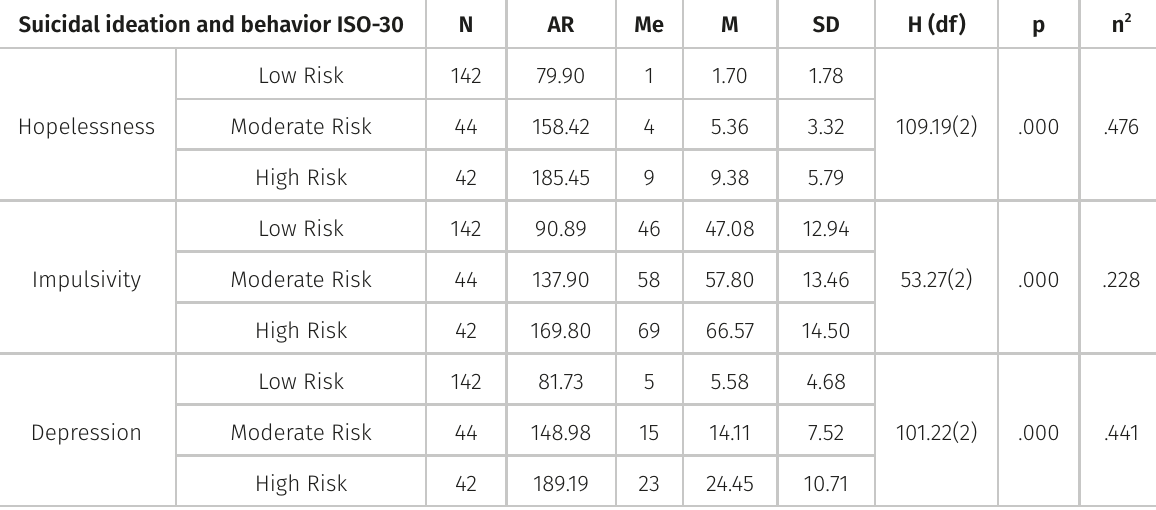
Table I. Differences between students based on the risk of suicidal ideation and behavior and the variables of hopelessness, impulsivity, and depression. Suicidal ideation and behavior